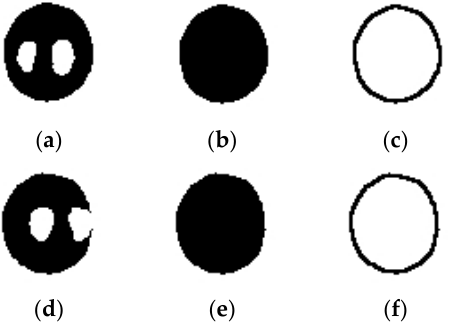
Figure 5. Pupil reconstruction stages when the corneal reflection is placed inside the pupil area and when it is located on the pupil edge: ( a , d ) eye pupil images after the binarization stage; ( b , e ) morphological reconstructions by dilation, filling the gaps due to corneal reflection and erosion; and ( c , f ) pupil contour detection.